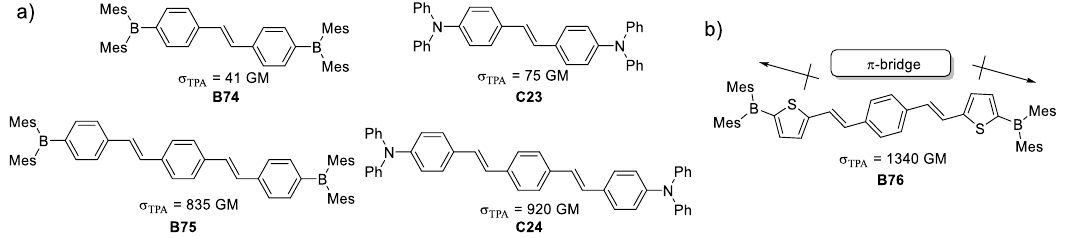
Figure 29. Quadrupolar organoboron species with different lengths of π-bridges. ( a ) Quadrupolar architectures varying the direction of electron density and π-bridge length; ( b ) design for TPA responsive molecule.